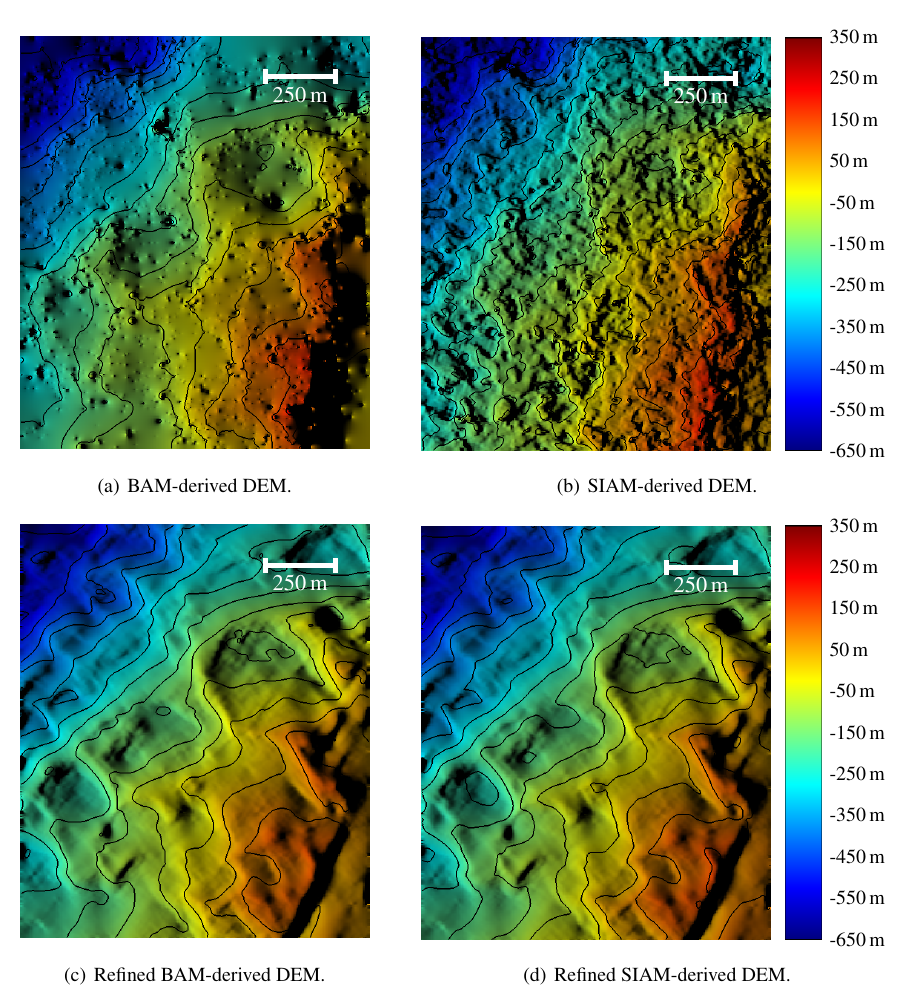
Figure 4: Contour plots of the DEMs. The 20 contours are equally spaced between − 650 m and 350 m. The based maps are created by encoding the height in colors and multiplying the intensity of each image by a Lambertian shading of the DEM. Black dashed lines represent the contours. (a) DEM obtained using BAM. (b) DEM obtained using SIAM. (c) SfS result using the BAM-derived DEM. (d) SfS result using the SIAM-derived DEM.